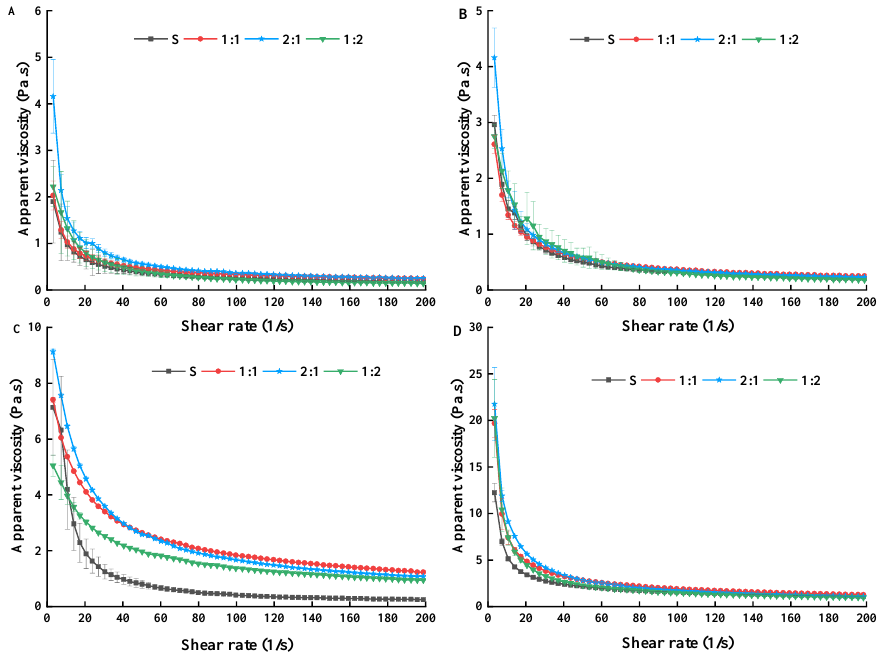
Figure 3. Changes in apparent viscosity of yogurt supplemented with different proportions of MC5 during storage. ( A – D ) Apparent viscosity of the four groups of yogurt milk on the 1st, 7th, 14th, and 21st days in storage, respectively. Error bars represent the standard errors (se) of the model-fitted mean value ( n = 3). “a, b, c, d” indicate significant differences within yogurt groups during storage at p <